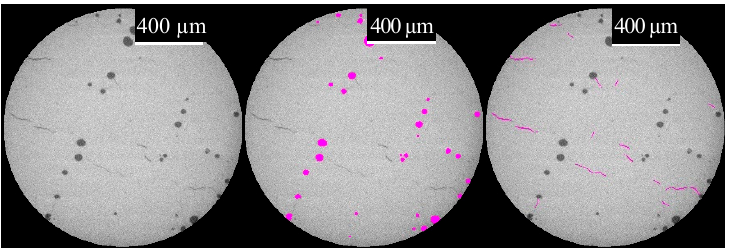
Figure 7. ZEISS sample segmented image. Left : original image, Center : pores, Right : cracks.